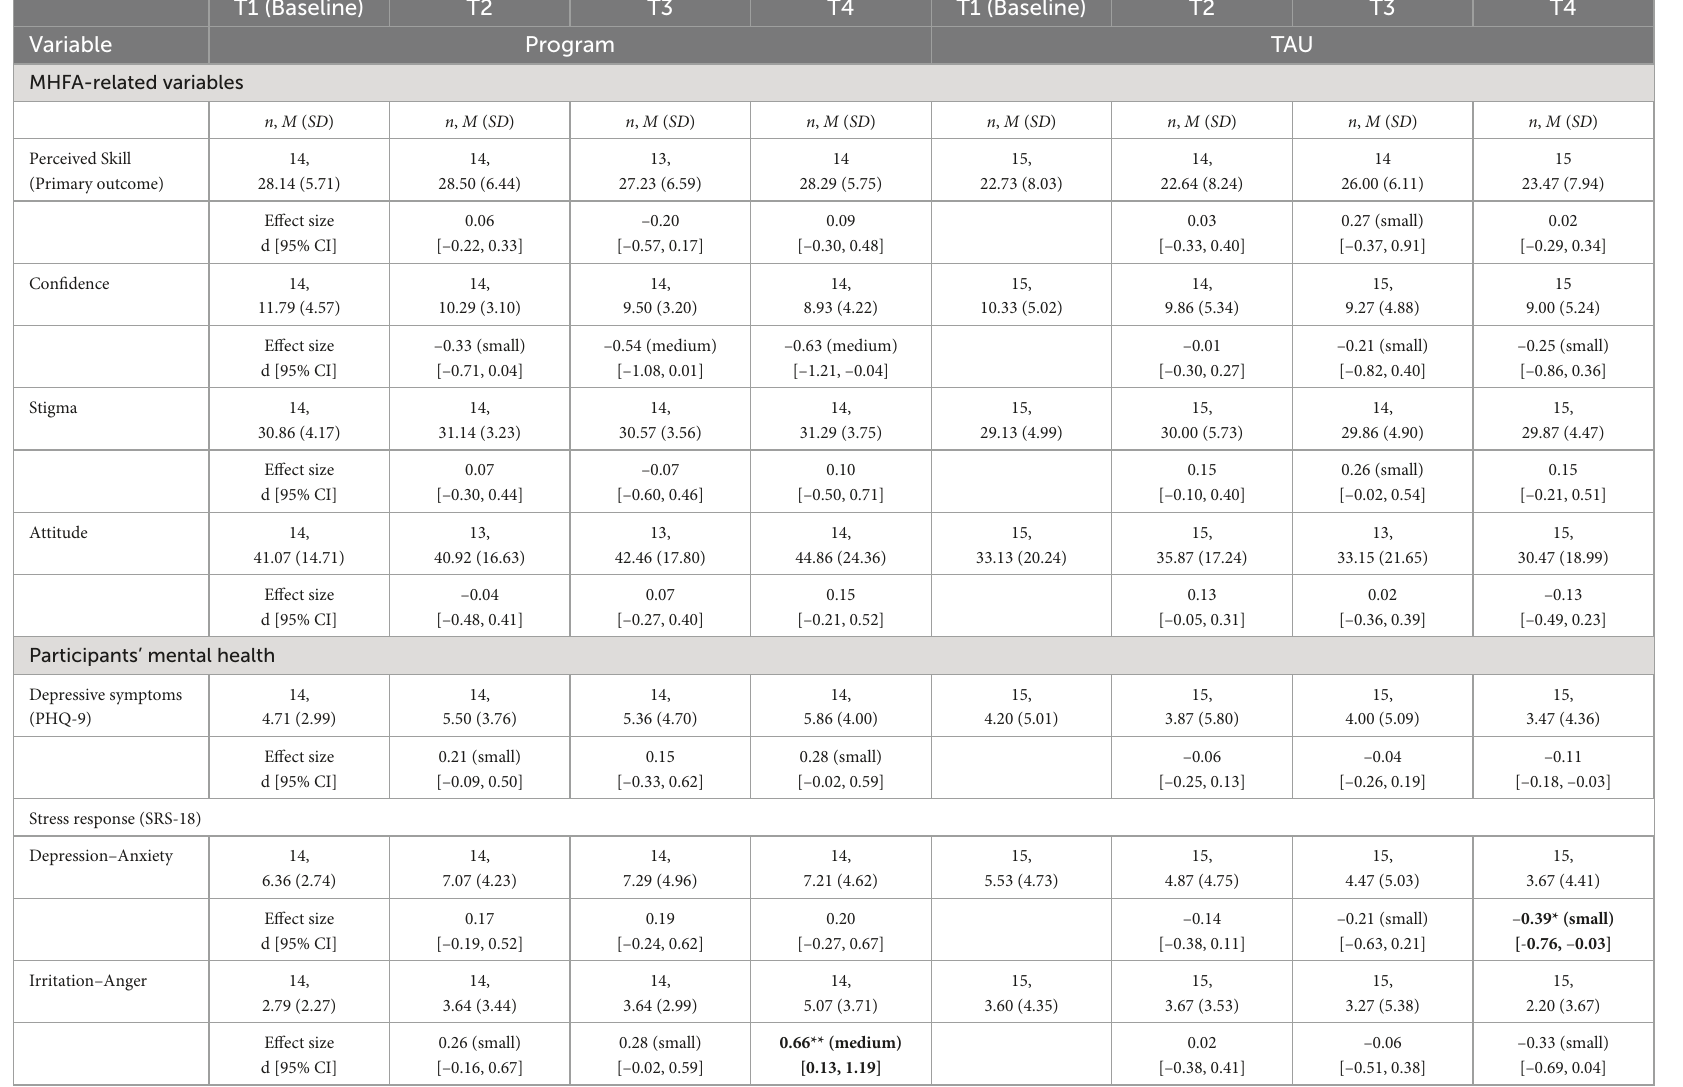
TABLE 3 Changes in self-administered questionnaires and behavioral changes in hikikomori sufferers reported by